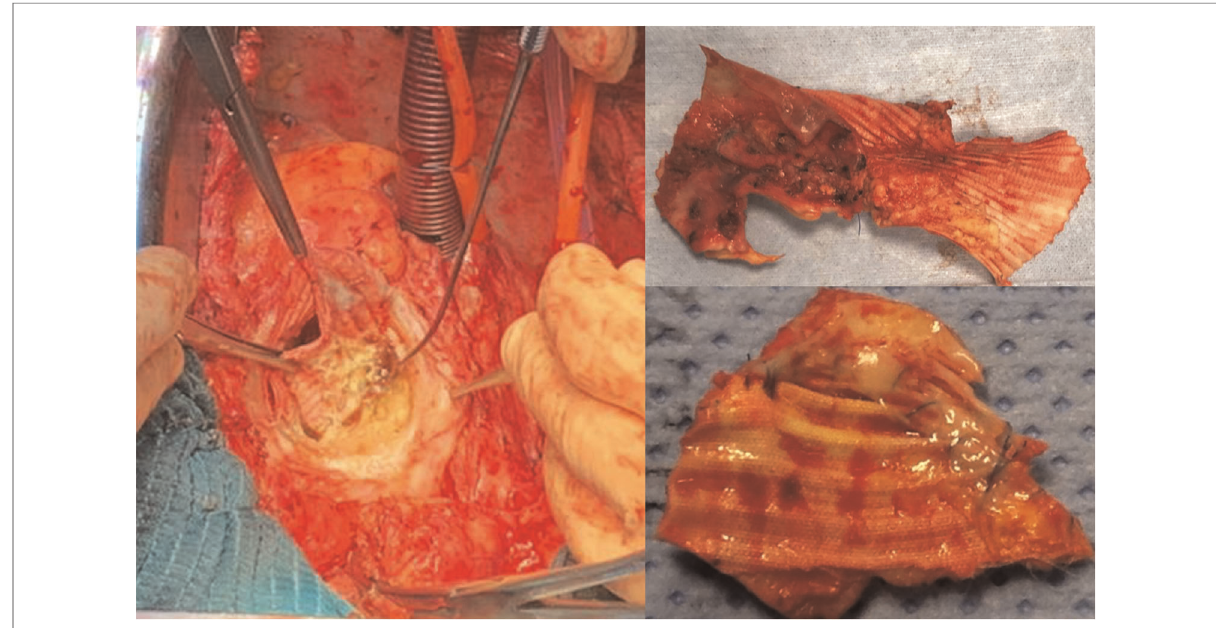
FIGURE 1 Intraoperative fi ndings of damaged polypropylene suture and discontinuity between the aortic wall and the vascular graft at the proximal anastomotic site where BioGlue ® was used in a patient undergoing prior aortic dissection